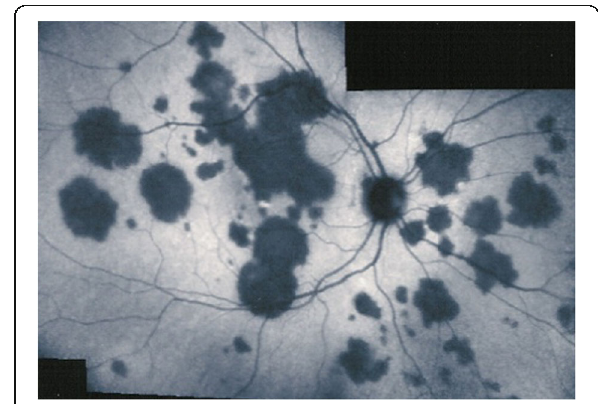
Fig. 4 Indocyanine green angiography (ICGA), type 1 pattern: choriocapillaris non-perfusion. Typical geographic areas of dark non fluorescence in case of acute posterior multifocal placoid pigment